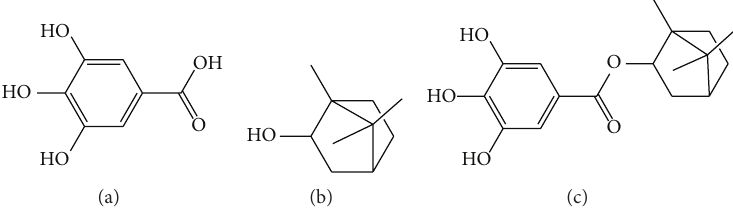
Figure 1: Chemical structures of gallic acid (a), borneol (b), and bornyl gallate